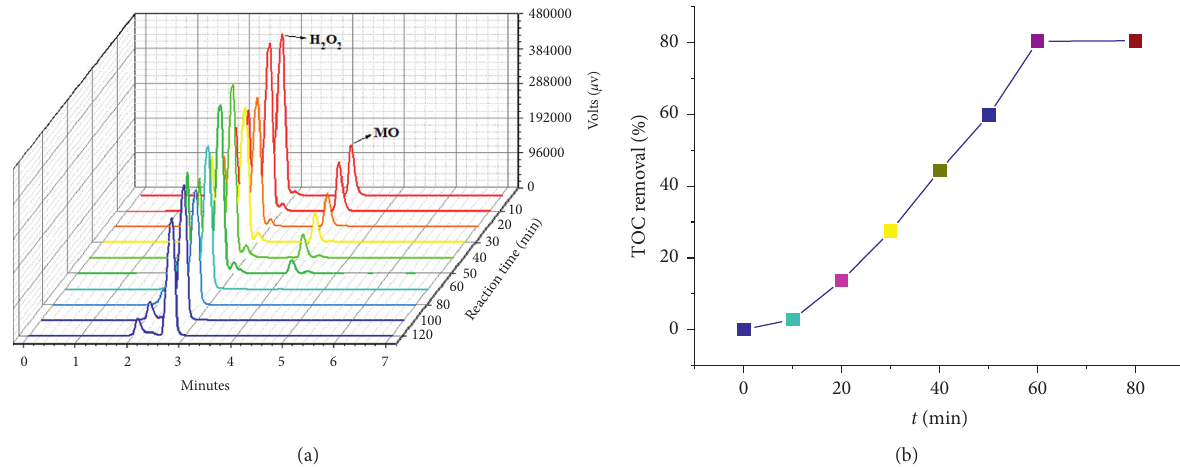
Figure 12: (a) HPLC chromatography and (b) %TOC of the reaction solution containing MO and hydroperoxide at different time intervals (experimental conditions: 0.5g/L of the catalyst; 60mg/L MO; 0.192M · H 2 O 2 ; temperature 30 ° C; UV radiation).